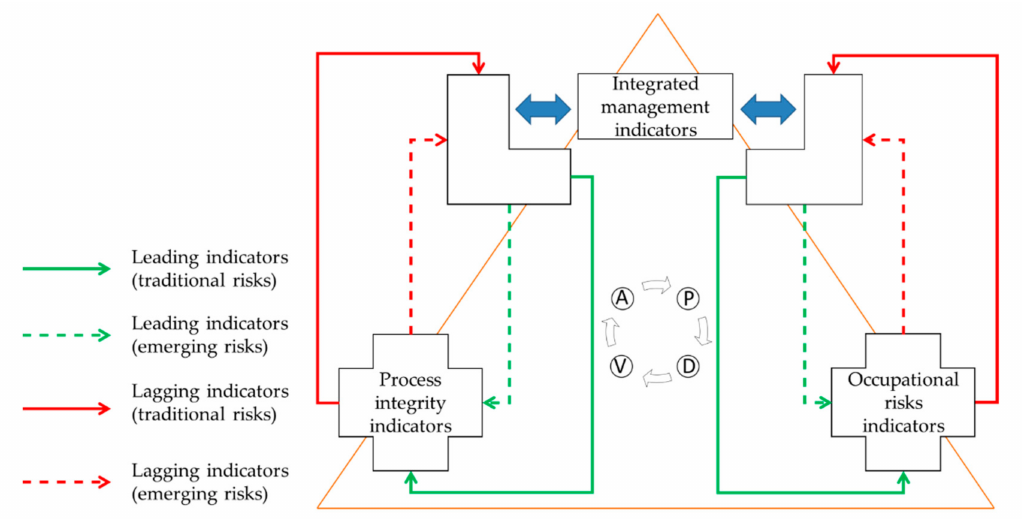
Figure 2. Integration of leading and lagging indicators in an IMS (Own elaboration).